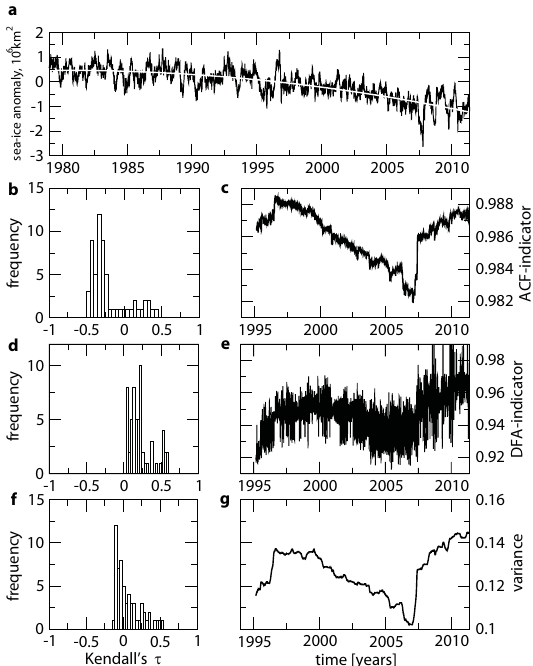
Fig. 6. (a) Detrended deseasonalised model data (Fig. 4) and its early warning indicators: (b) ACF-indicators (with and without lin- ear detrending within sliding windows); (c) DFA-indicator; (d) vari- ance. 100 days, which should be long enough to capture the slow- est recovery mode of the sea